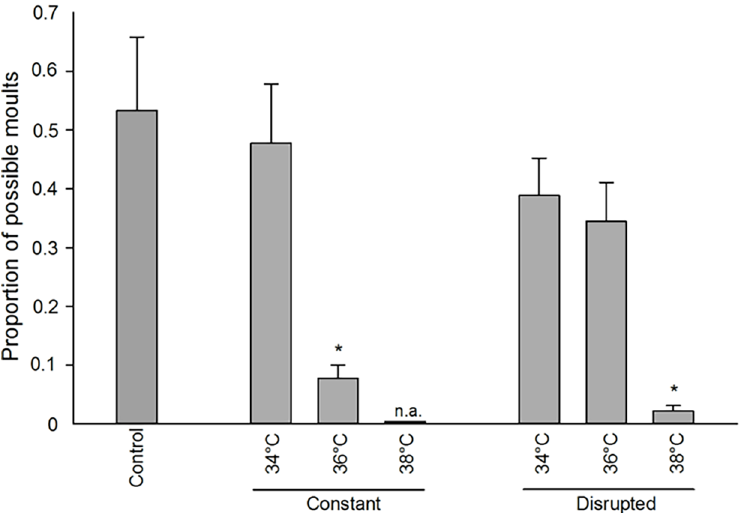
Fig 5. Long-term heat stress effects in Cimex lectularius . Development (proportion of possible moults per nymph) of Cimex lectularius first instar nymphs produced by adults that had been heat treated 7 weeks earlier. The nymphs were fed every 14 days and kept at 22˚C for a total of 8 weeks. Each treatment is represented by five boxes with six nymphs each. Data from the 2 and 3 week treatments are pooled, except for the constant 34˚C for which only 3 week data were available. No nymphs were produced at a constant 38˚C (n.a.). (cid:3) denotes significant difference relative to control (Dunnett’s method, p <